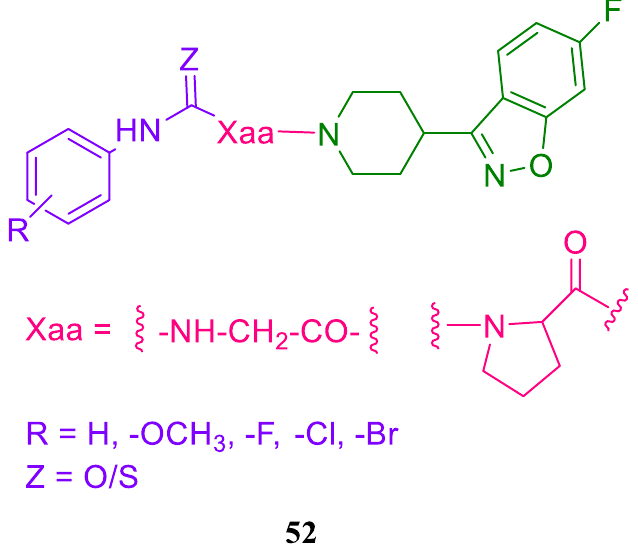
Figure 47. Pro/Gly conjugated with benzisoxazole derivatives.